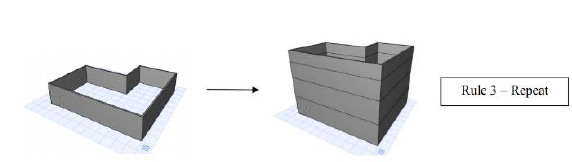
Figure 11. Rule 3 - Repeat Wall Instance for Any Number of Floors.